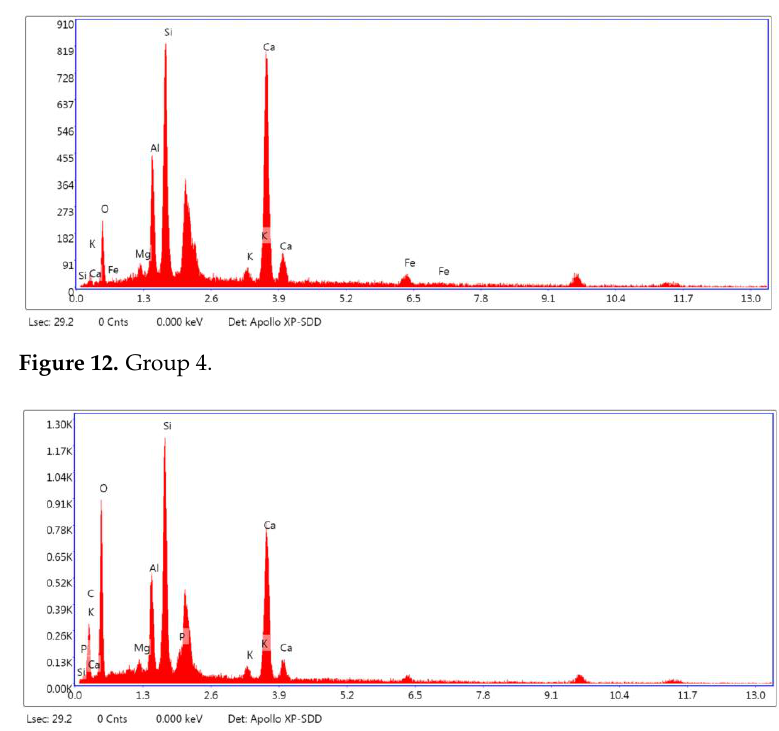
Figure 13. Group 7. Table 5. The element composition of CLSM.